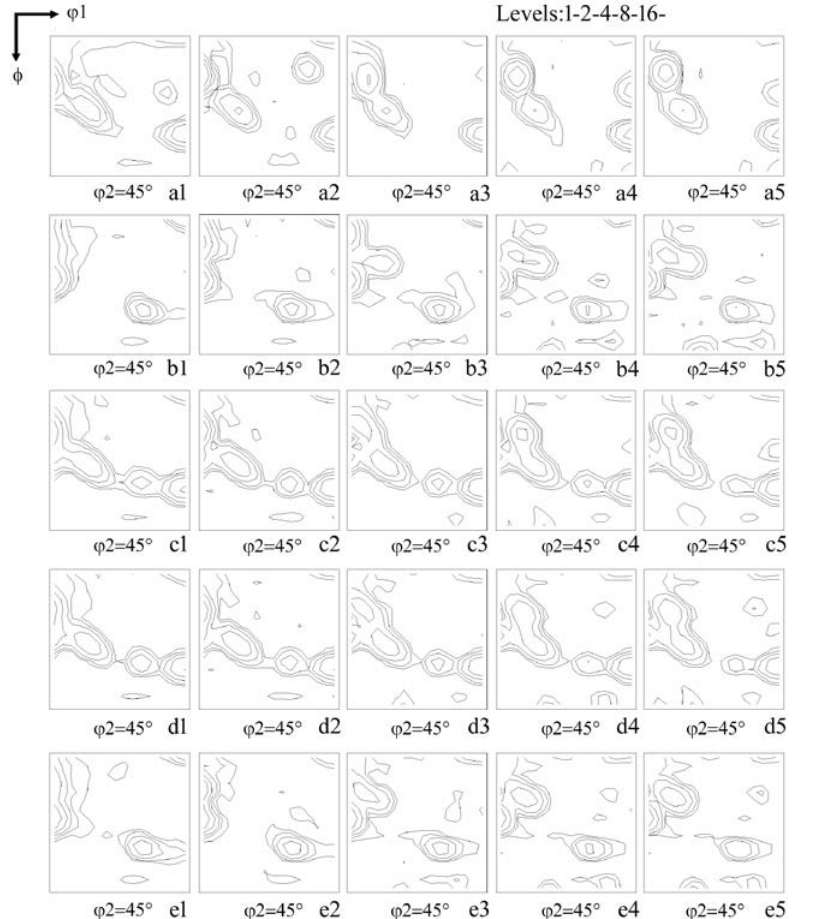
Figure 3. Effects of α ij s on calculated rolling deformation textures at ε 33 = − 1.1 when considering different activation abilities of {110}<111> and {112}<111> slip systems. {110}<111> slip: ( a1 ) α ij s = 0.2;